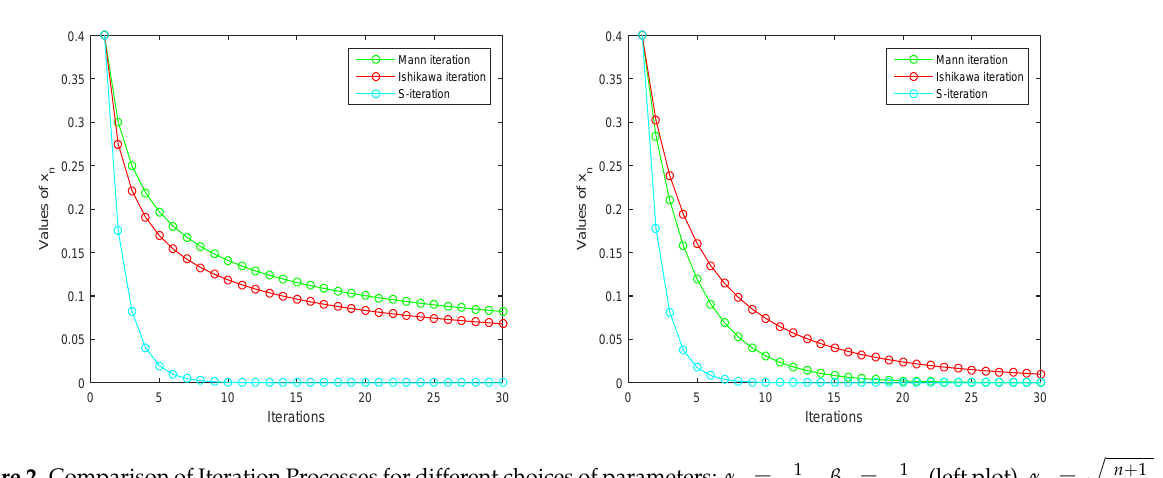
, β n = 1 (left plot), α n = n + 1 n + 1